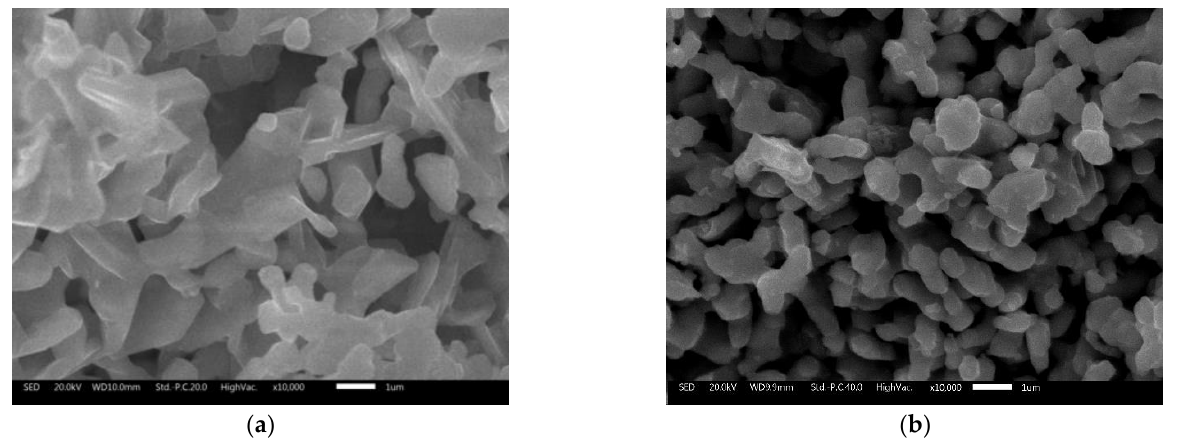
Figure 5. SEM images of perovskite products; ( a ) SGB experiment; ( b ) G experiment. The samples are polycrystalline with interconnected pores in its structure and accumulation of particles (crystalline aggregates).